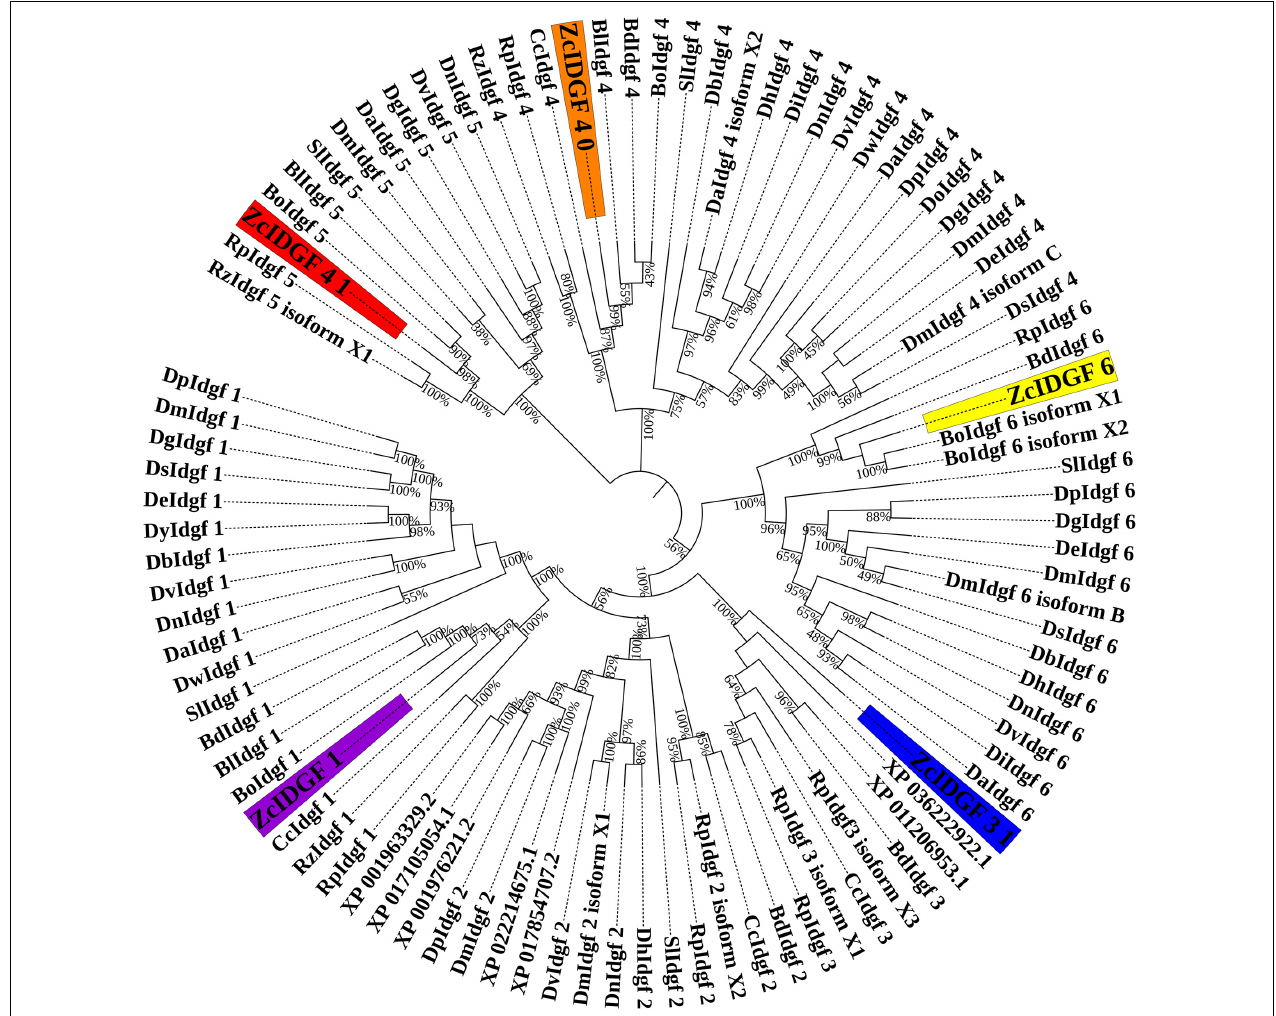
FIGURE 1 | Phylogenetic analysis of IDGFs genes with model family Tephritidae (taxid: 7211) and Drosophilidae (taxid: 7214) are shown in the tree. The highlighted part indicates our target genes. Tree indicates relationship between IDGFs gene and species tree. Maximum likelihood method was used to construct insects IDGFs coding sequences phylogenetic tree. Complete details of all IDGFs are listed in Supplementary Table 1